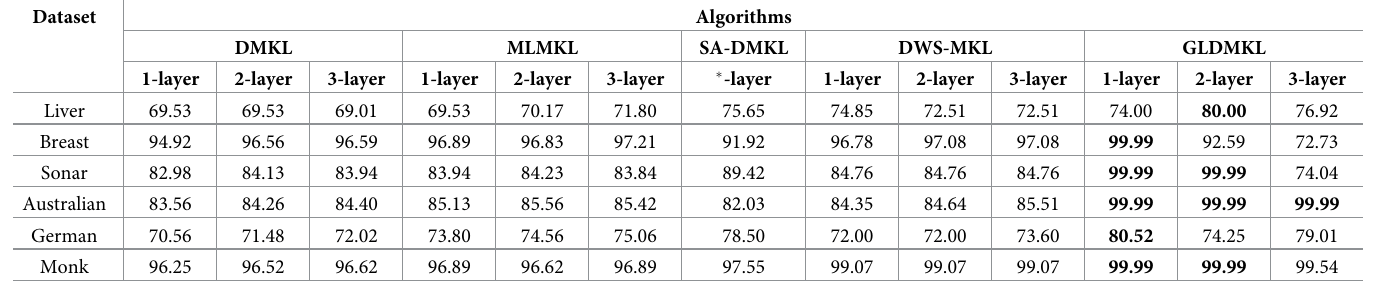
Table 5. Comparison of classification performance(%) at each